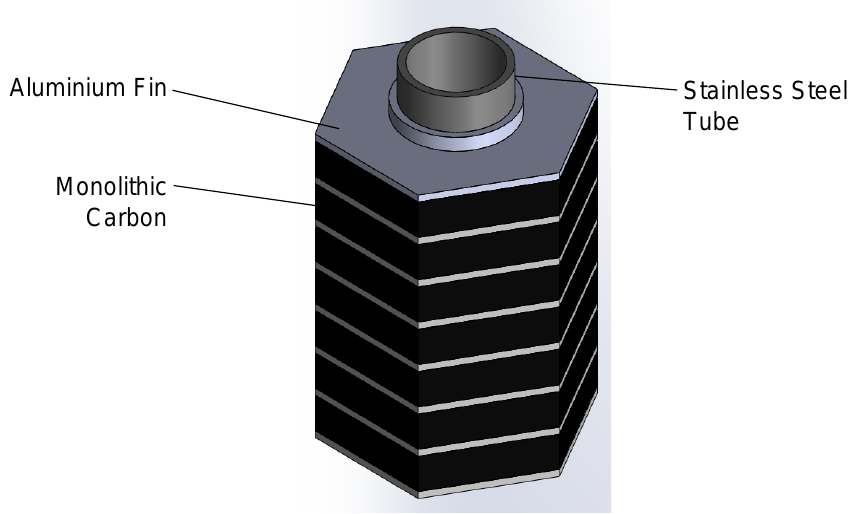
Figure 2. Round-tube and fin generator concept.